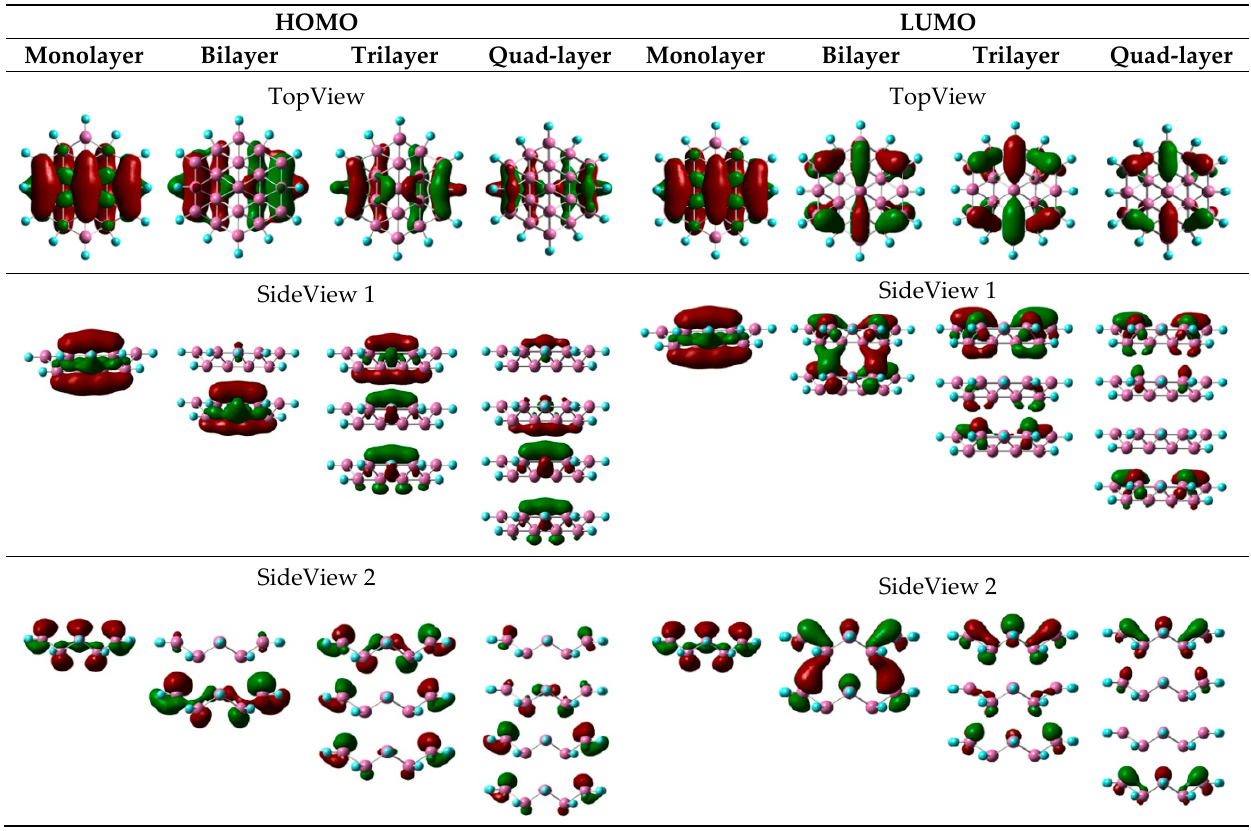
Figure 6. The top and side views of the HOMO and LUMO of the mono- bi-, tri-, and quad-layer of the borophene nanoflake.